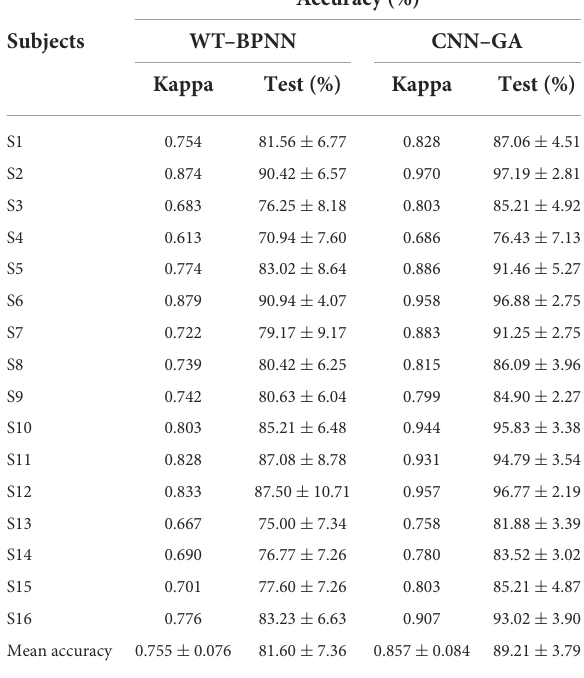
TABLE 3 Averaged accuracies of each subject under WT–BPNN and CNN–GA